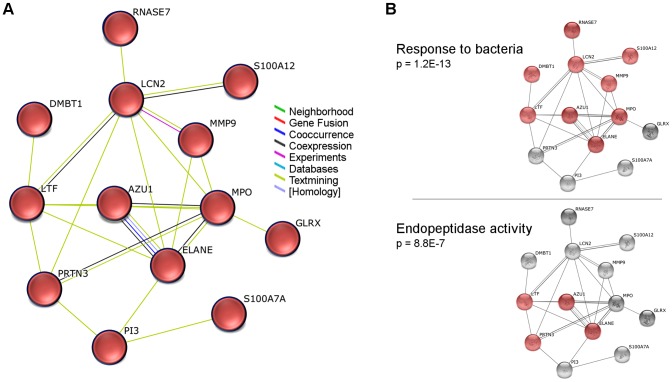
Synthesized network of immune response-related up-regulated proteins in cholesteatoma and neck of cholesteatoma.A. All proteins showed higher protein levels in cholesteatoma and neck of cholesteatoma compared to the external auditory canal skin. The proteins met the fold change criteria in at least one of the two tissue comparisons. B. Examples of significant associations of the network with: GO Biological Processes, GO Cellular Components and KEGG Pathways; ordered by p value. The networks were generated in STRING.